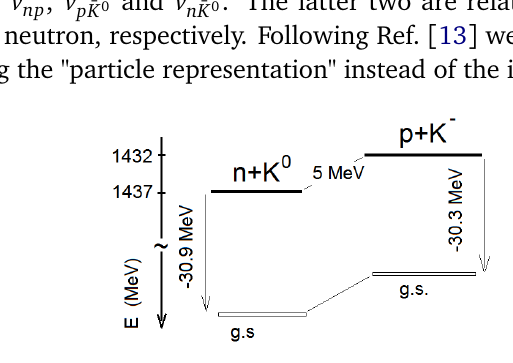
Figure 1: The mass differences for the systems n + ¯ K 0 and p + K − . The binding energies of the ground states for the n + ¯ K 0 and p + K − are calculated with the AY effective isospin singlet N ¯ K potential [ 12 ] . The Coulomb force is not included in calculations for p + K −